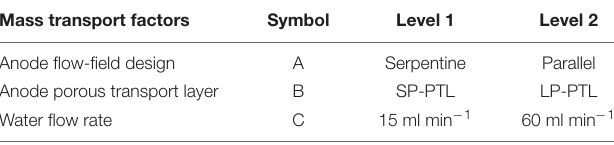
TABLE 1 | Design factors and their